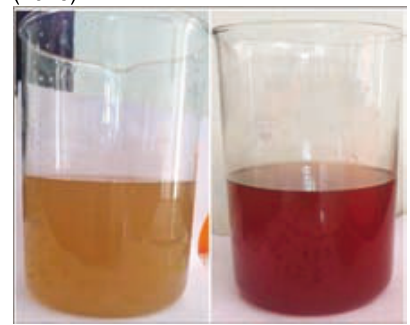
Fig. 3. Colour change from yellow to dark